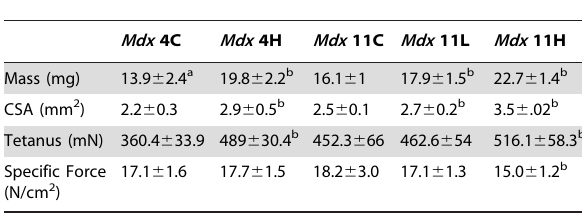
Table 2. Functional properties of EDL muscle in mdx groups.